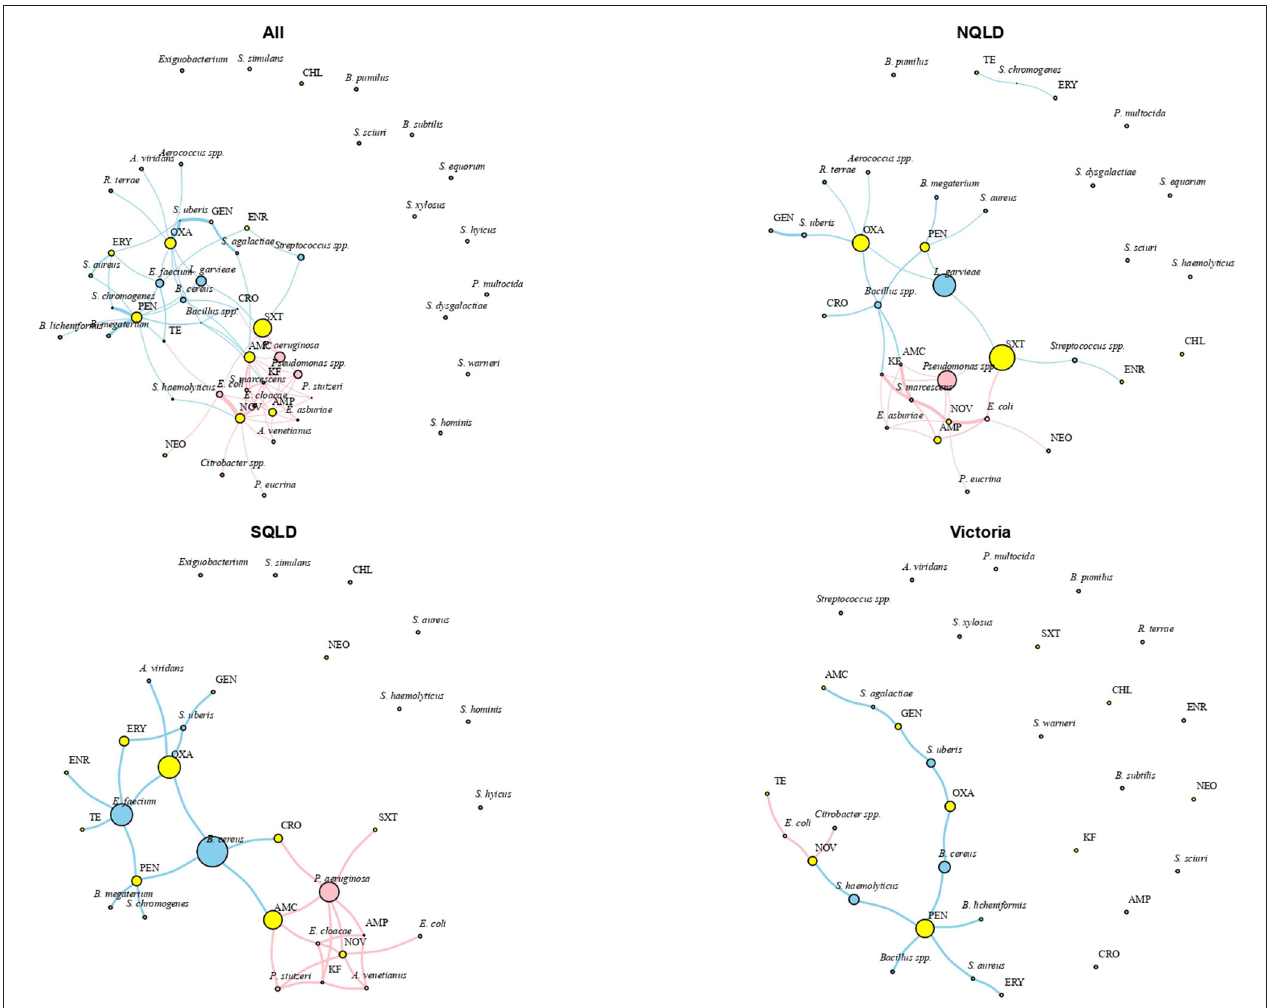
FIGURE 4 | Social network analysis of antimicrobial resistance patterns of isolate groups and antimicrobial agents for the study population. Network constructed using multidimensional scaling and shortest path as the distance matrix with the size of the nodes proportional to antimicrobial agent and isolate group eigenvector values. The eigenvector score is a measure of isolate or antimicrobial agent importance based on their overall centrality degree in the network. Key: blue, Gram-positive bacteria; pink, Gram-negative bacteria; AMC, amoxicillin-clavulanic acid; AMP, ampicillin; CHL, chloramphenicol; CRO, ceftiofur; ENR, enrofloxacin; ERY, erythromycin; GEN, gentamicin; KF, cephalothin; NEO, neomycin; NOV, pen-novobiocin; OXA, oxacillin; PEN, penicillin; SXT, cotrimoxazole; TE, tetracycline. NQLD, Northern Queensland; SQLD, Southeast